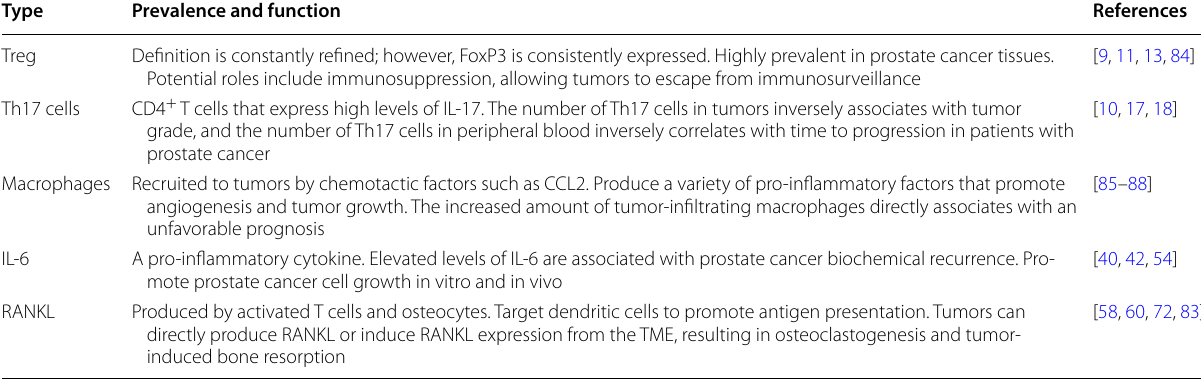
CCL2 chemokine (C–C motif) ligand-2, IL-6 interleukin-6, IL-17 interleukin-17, RANKL receptor activator of nuclear factor kappa-B ligand, Th17 T helper 17, Treg T-regulatory cell, TME tumor microenvironment, FoxP3 forkhead box